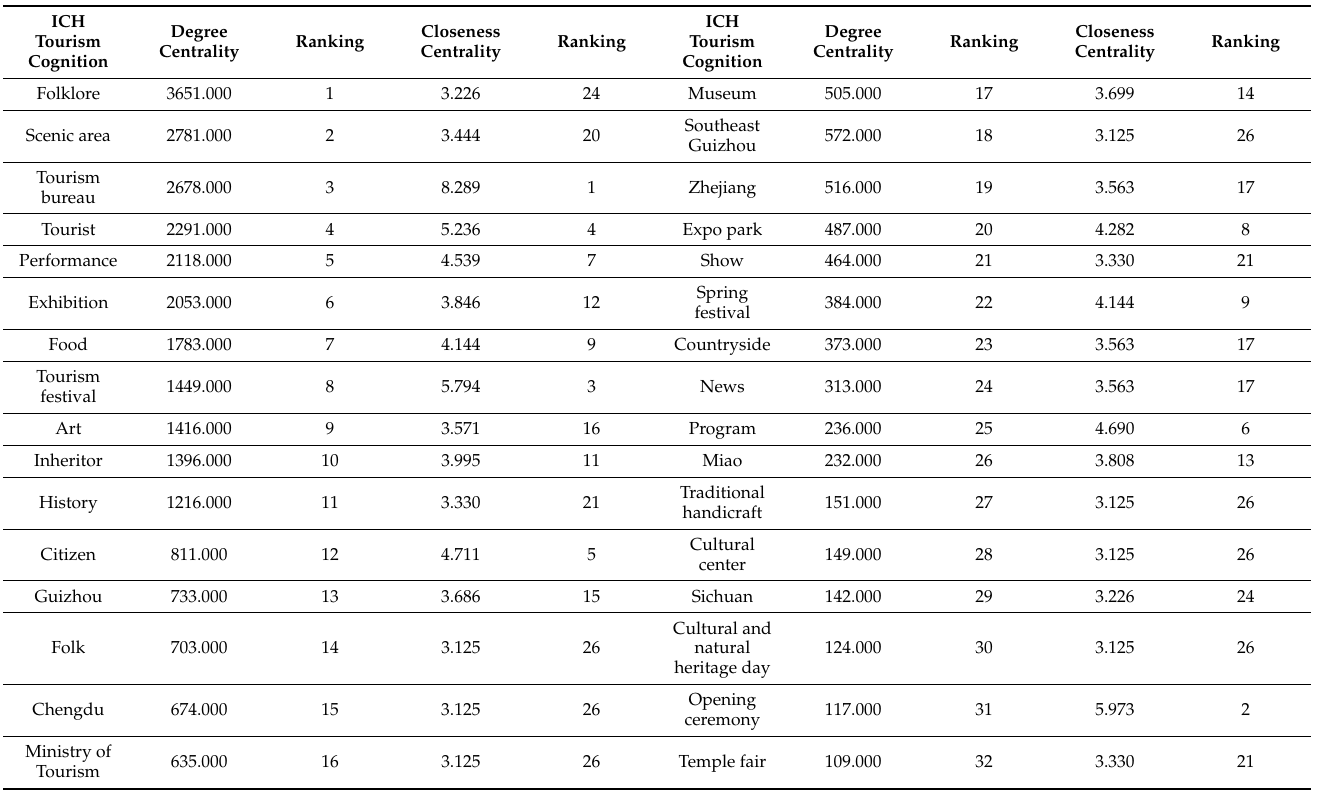
Table 5. Centrality analysis results of ICH tourism